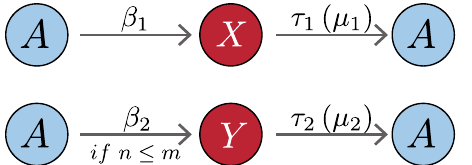
Fig. 1 Schematic illustration of NMR and MR models. An active ( A -type) node may fail spontaneously at the rate β 1 to become an X -type node due to internal causes, or it may fail at the rate β 2 to become a Y -type node when the number of its A -type neighbors n is less than or equal to a threshold m setting the necessary neighboring support for the proper functioning of a node. In the NMR model, the X -type and Y -type nodes take the time duration τ 1 and τ 2 from the time they are generated to recover, respectively. In the MR model, the X -type and Y -type nodes recover, respectively at the rates μ 1 and μ 2 .